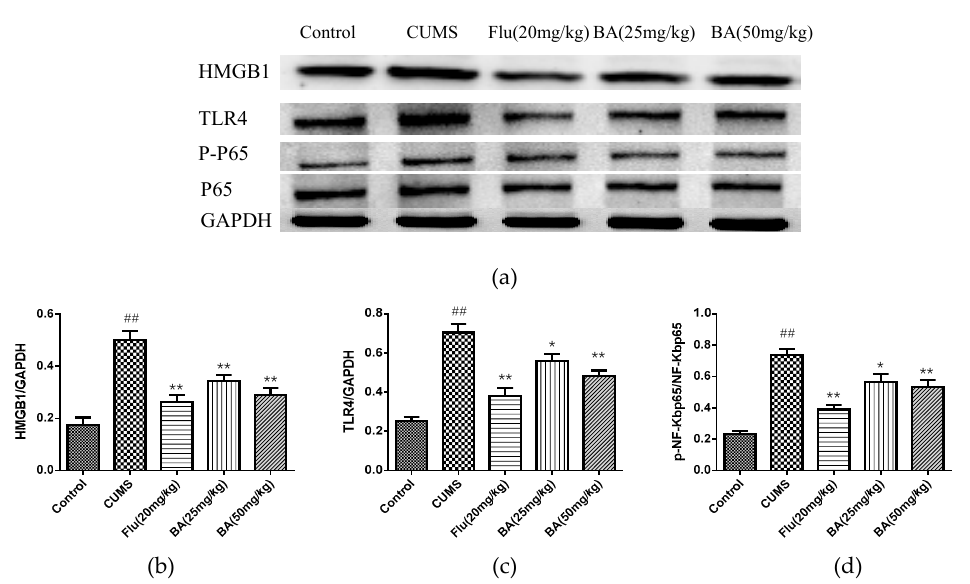
Figure 6. Effects of BA on ( a , b ) HMGB1/ ( a , c ) TLR4/ ( a , d ) NF- κ B signaling pathway in mice ( n = 3). Data were expressed as mean ± SEM ( n = 6). ## p < 0.01 vs. the control; ** p < 0.01, * p < 0.05 vs. the